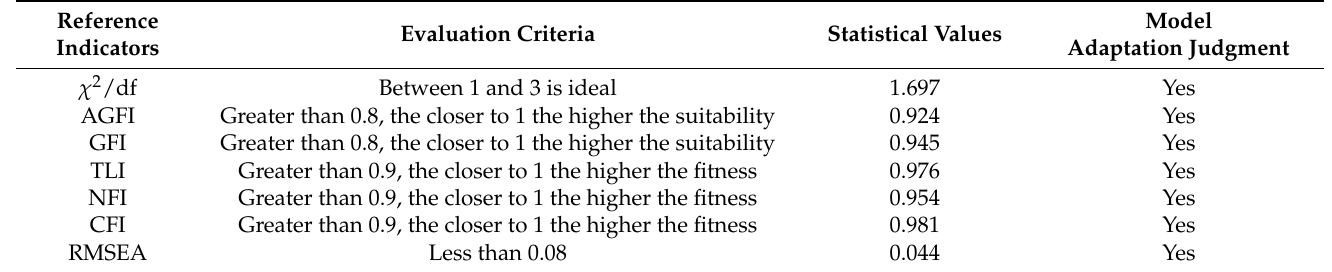
Table 12. Model fit goodness of fit index.